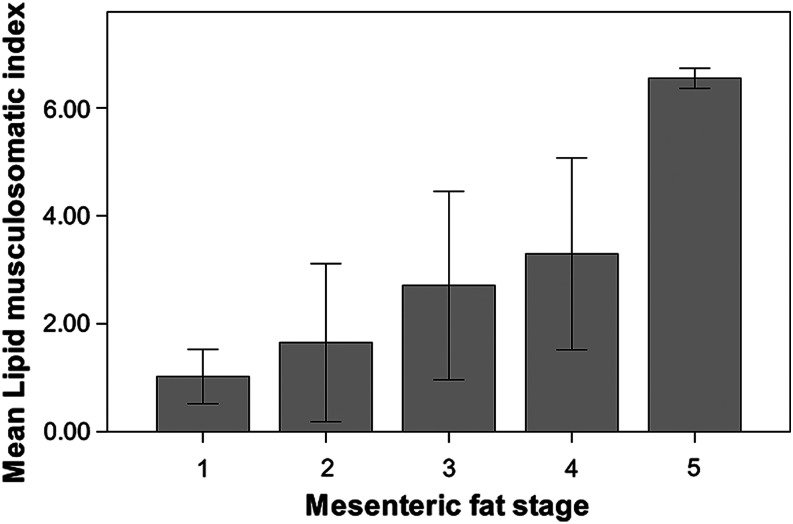
Mean lipid musculosomatic index (ILM) of anchovies in relationship to mesenteric fat stages. The bars represent ±SD.